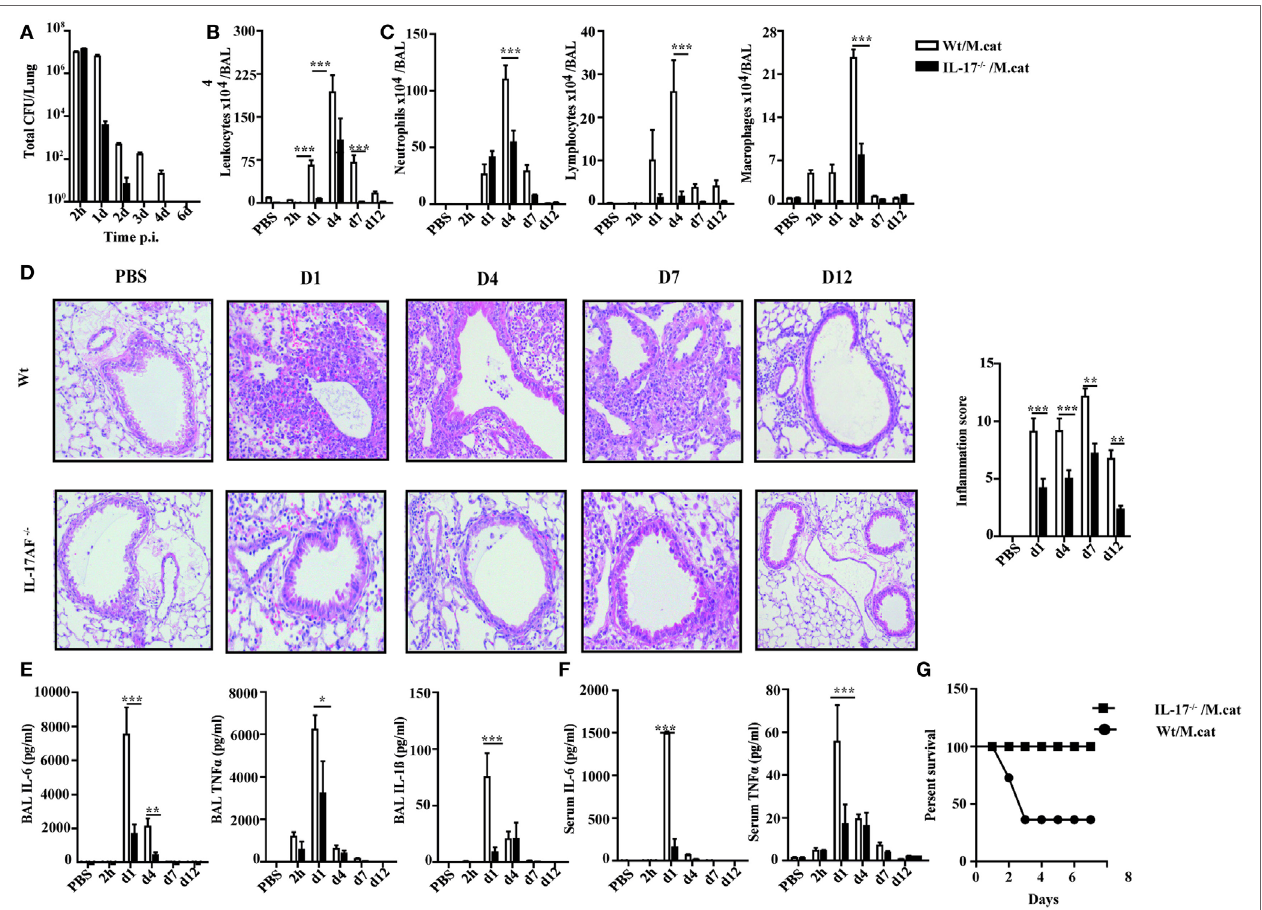
FigUre 2 | Reduced inflammatory response to M. catarrhalis infection in IL-17 KO mice. IL-17 KO (black bars) and wt mice (white bars) were infected (i.n.) with 2 × 10 8 CFU M. catarrhalis. BAL, lungs, and serum were harvested at indicated time points. (a) Bacterial CFU in lung homogenates were counted at different time points after infection. (B) Airway inflammation represented by BAL total cell counts. (c) Differential cell counts in BAL. (D) Representative periodic acid Schiff-stained airways of wt and IL-17 KO mice (e) Amounts of IL-6, TNF- α , and IL-1 β in BALF. (F) IL-6 and TNF- α in serum. (g) Survival of IL-17 KO (squares) and wt animals (circles) after infection. Data were from two independent experiments ( n = 10 mice per group). *** P = 0.001, ** P = 0.01, and * P = 0.05 (one-way ANOVA). BAL, bronchoaleveolar lavage; BALF, BAL fluid; ANOVA, analysis of